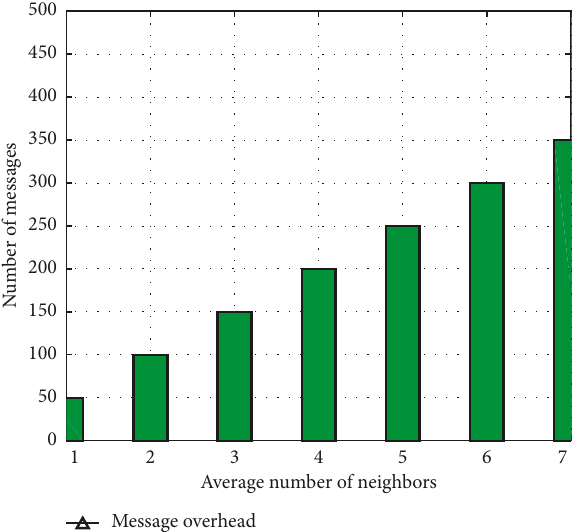
Figure 7: Memory overhead in a clustered WSN.